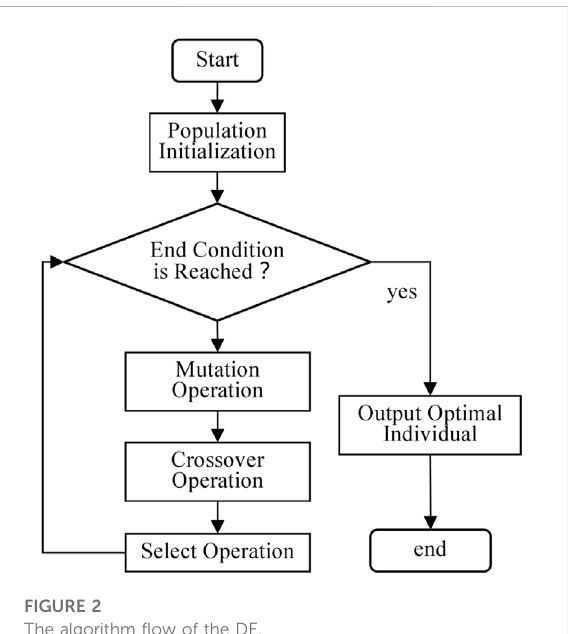
FIGURE 2 The algorithm fl ow of the